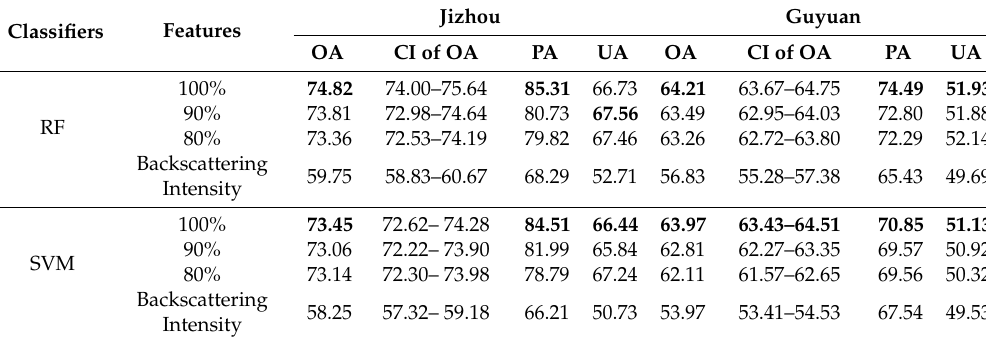
Table 4. The classification accuracy of PMF using Radarsat-2